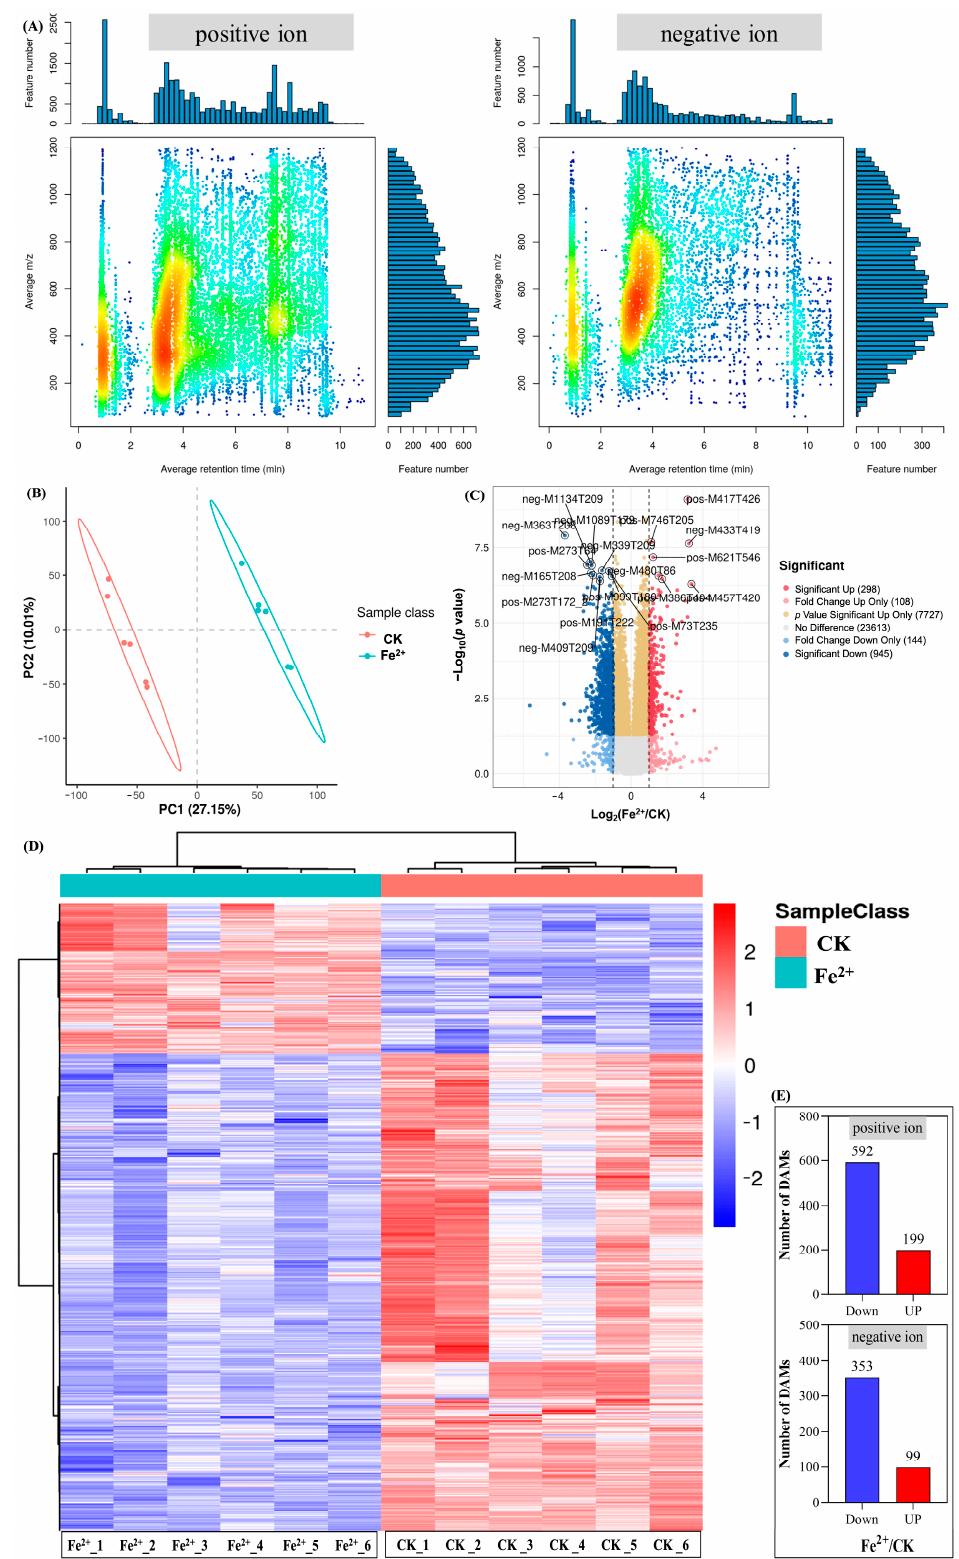
Figure 6. Basic metabolite information of Fe 2+ (2500 mg·L − 1 ) and CK based on widely untargeted metabolomics. ( A ) M / z -RT distribution of metabolites. ( B ) PLS-DA score plot of metabolites. ( C ) Significance analysis of the DAMs between the Fe 2+ and CK determined by Volcano plot. ( D ) Fe 2+ regulated the metabolites of E. sagittatum leaves. ( E ) Number of DAMs between Fe 2+ and CK.